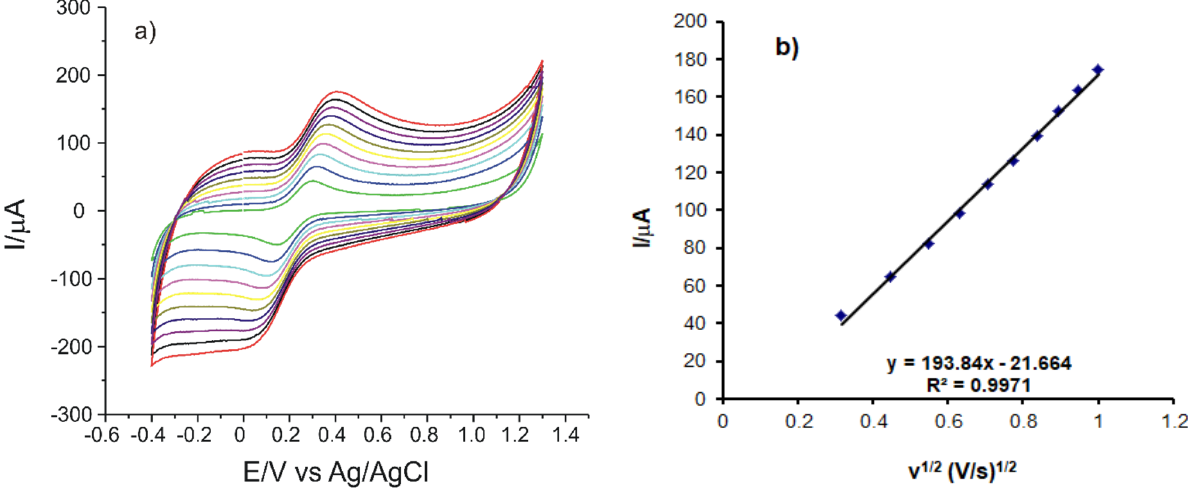
Figure 4. ( a ) CVs recorded by OMC-SPCE in a K 4 [Fe (CN) 6 ] 1.0 × 10 − 3 M-PBS 0.1 M solution at different scan rates (0.1–1.0 V · s − 1 ) and ( b ) Linear dependence between the anodic current and the square root of scan rate.